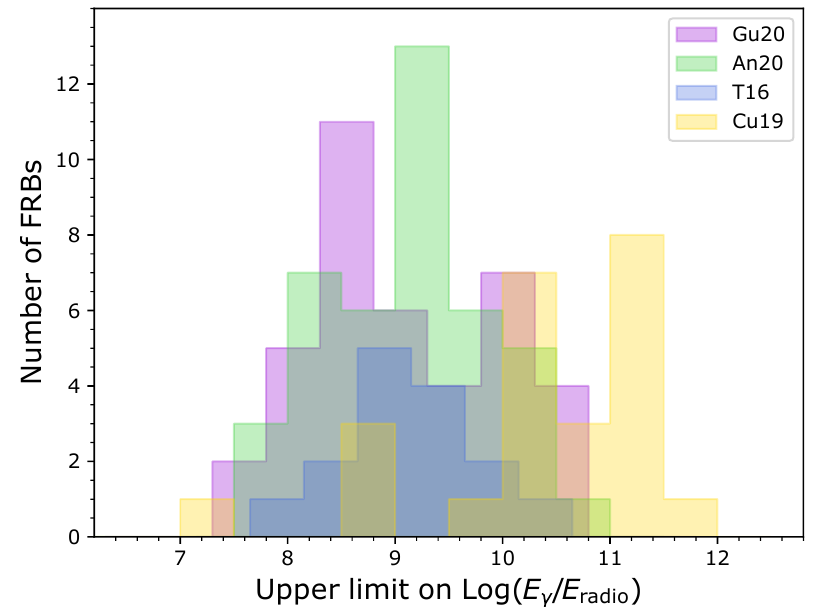
Figure 4. Distribution of upper limits on the logarithm of the ratio E γ / E radio obtained with hard X- / γ -ray detectors that were observing at the times of some FRBs for different samples and in different energy bands as reported in the literature: Gu20 refers to Insight-HXMT data obtained in two different bands, either 40–600 or 200–3000 keV [115]; An20 refers to AstroSat data in the 20–200 keV band [191]; T16 is based on the data from different detectors [55]; Cu19 is based on Fermi /GBM data in the 8–4 × 10 4 keV band, except for the Swift /BAT data of two bursts in the 15–350 keV band [190]. For all of them an integration time of 0.1 s was used, except for Gu20 for which 64 ms was